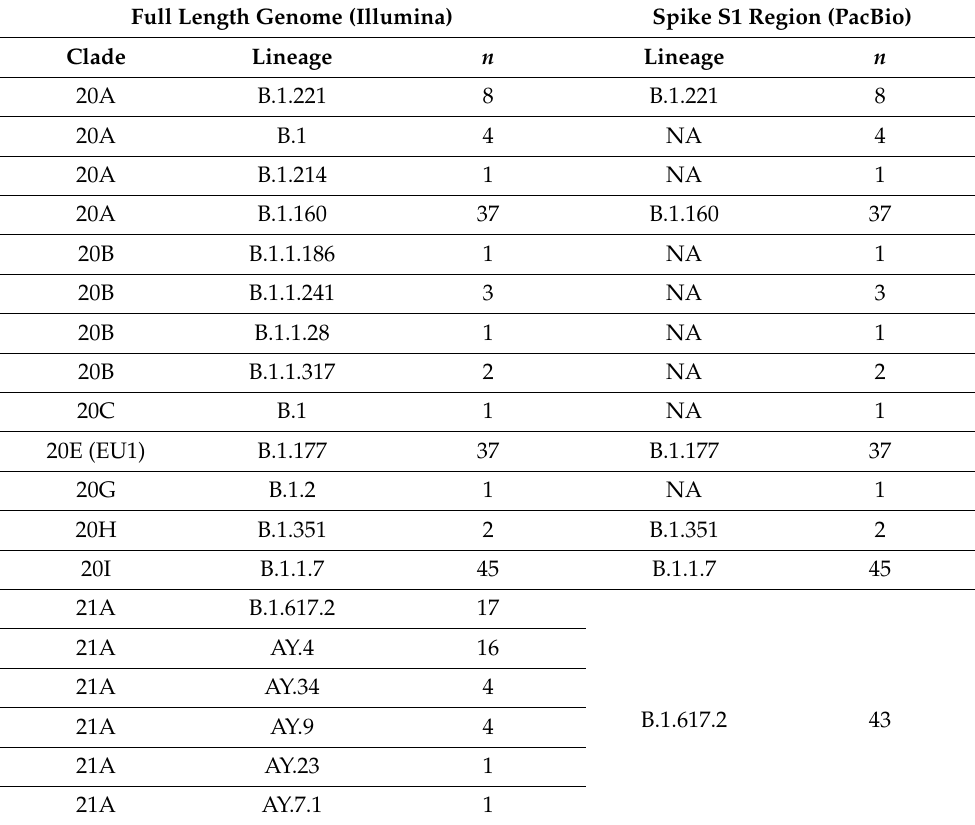
Table 4. Comparison of the lineages determined with full-length genomes and the S1-encoding region based on key